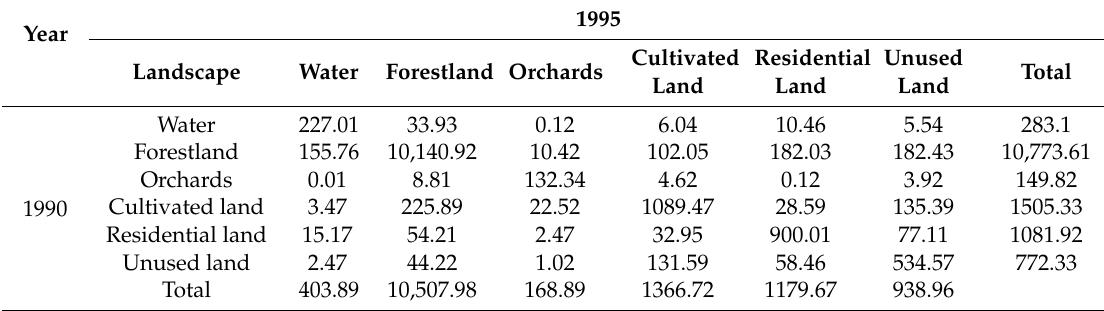
Table 18. The landscape transition matrix from 1990 to 1995 (km 2 ).